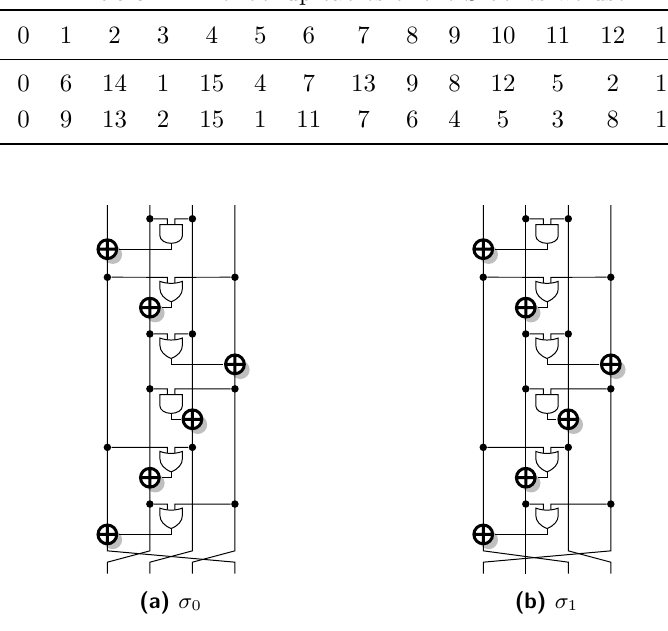
Figure 2: Bitslice implementation of the S-box